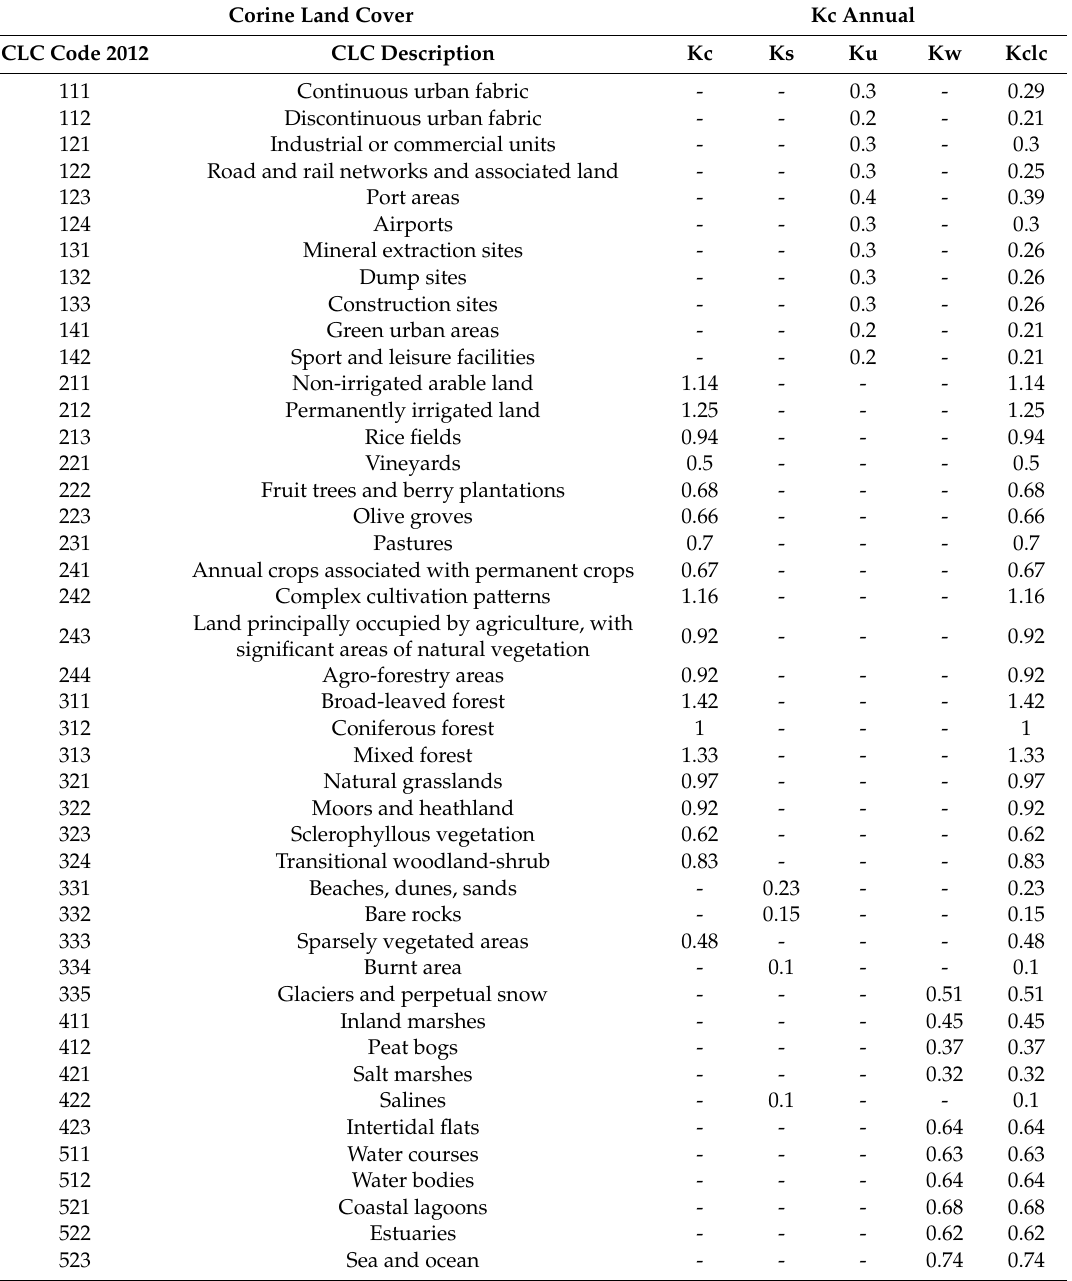
Table 1. Corine land cover classes and appropriate annual Kc for present in the Grand Est